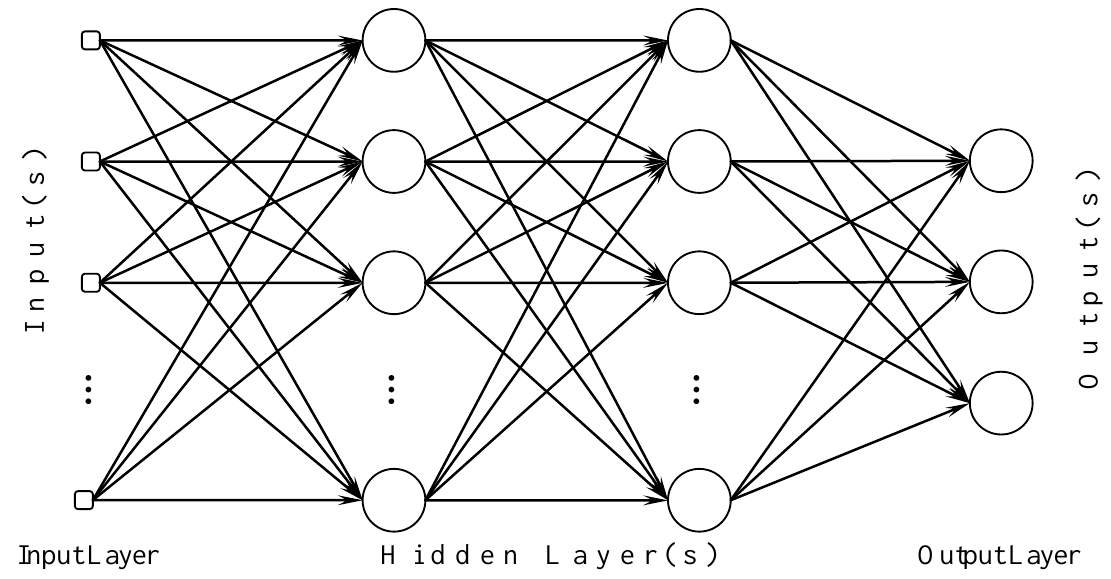
Figure 1. General structure of a multilayer perceptron